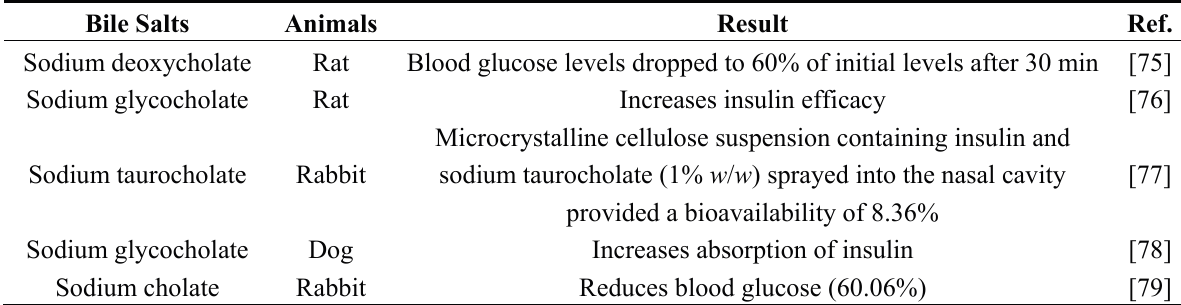
Table 4. Bile salts as absorption enhancers for nasal delivery of